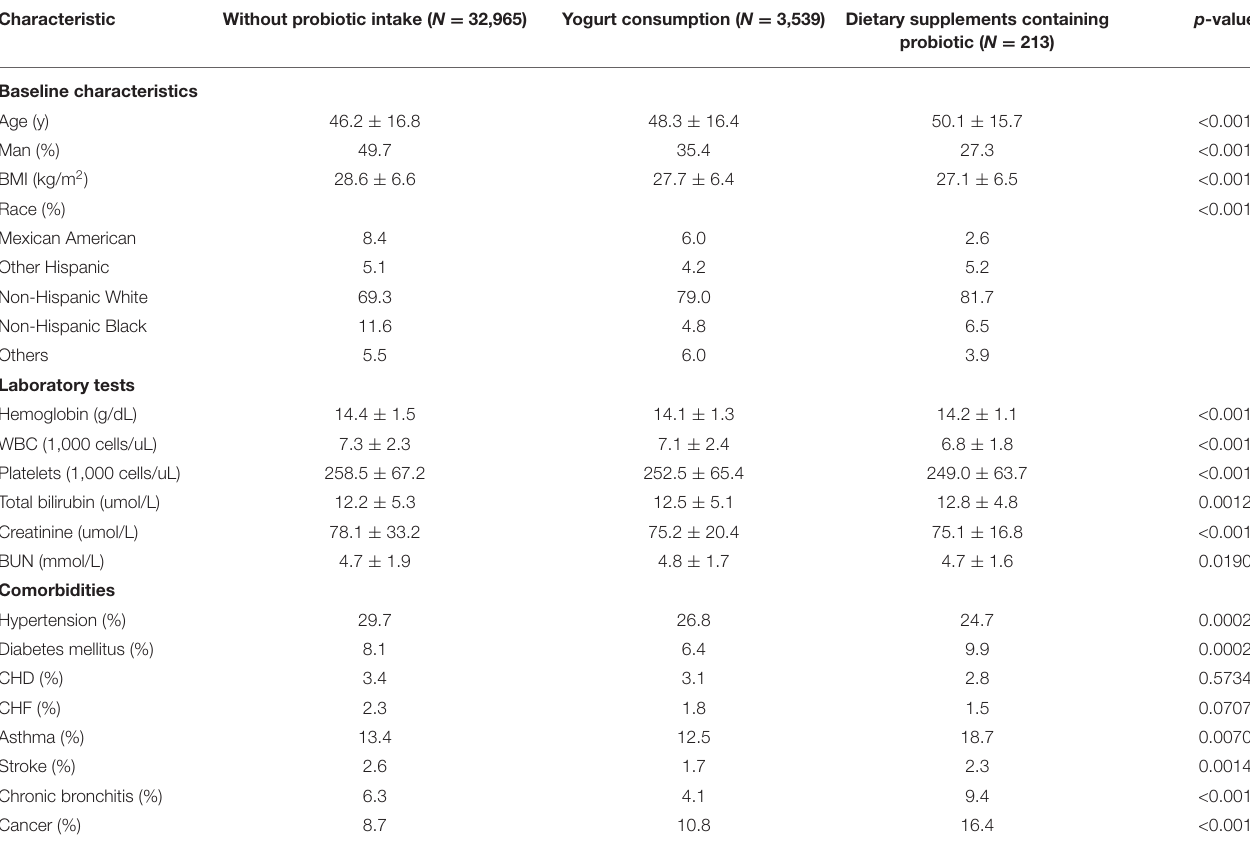
TABLE 1 | Participants baseline demographic and clinical characteristics.